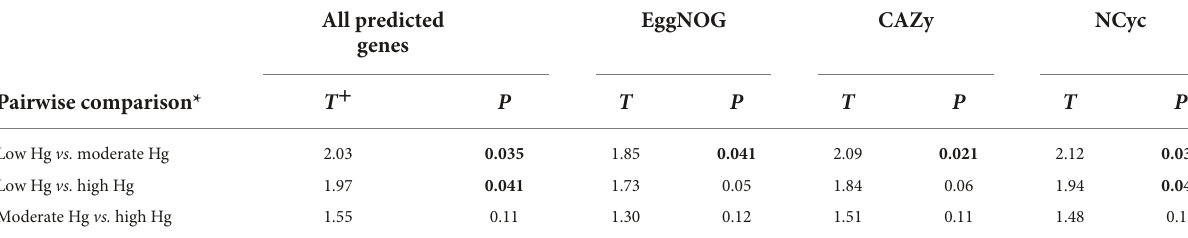
TABLE 3 Pairwise comparison of the functional gene beta-diversity of all predicted genes and of the genes annotated with the EggNOG, CAZy, and NCyc databases of soils with different Hg contamination levels (low, moderate, high). All predicted EggNOG CAZy NCyc genes